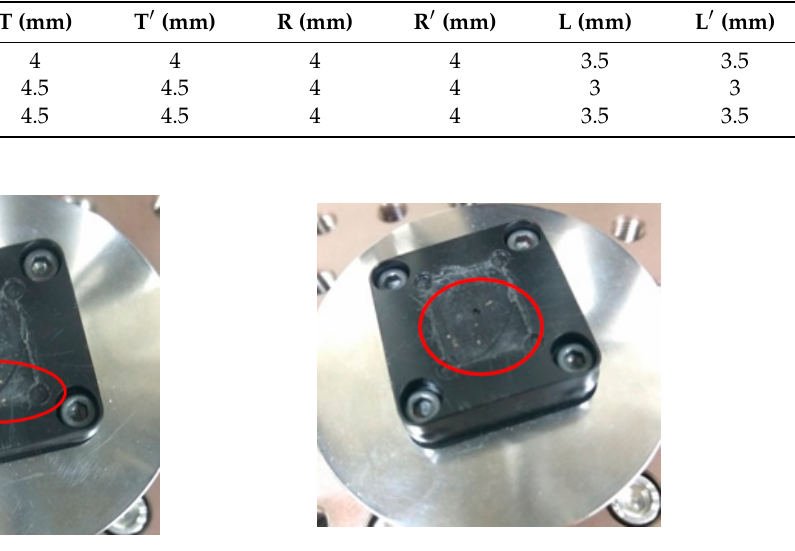
(b) Figure 16. Specimens observed under the OM. ( a ) Before test; ( b ) after test. For the dynamic compression tests, specimens were separated into small pieces to fit the fixture and loaded to 25% of their yield load with 1.5 million times. During the testing to 25% yield load, the displacement was about 0.02 mm without any big changes, as shown in Figure 17. All three specimens survived the test.